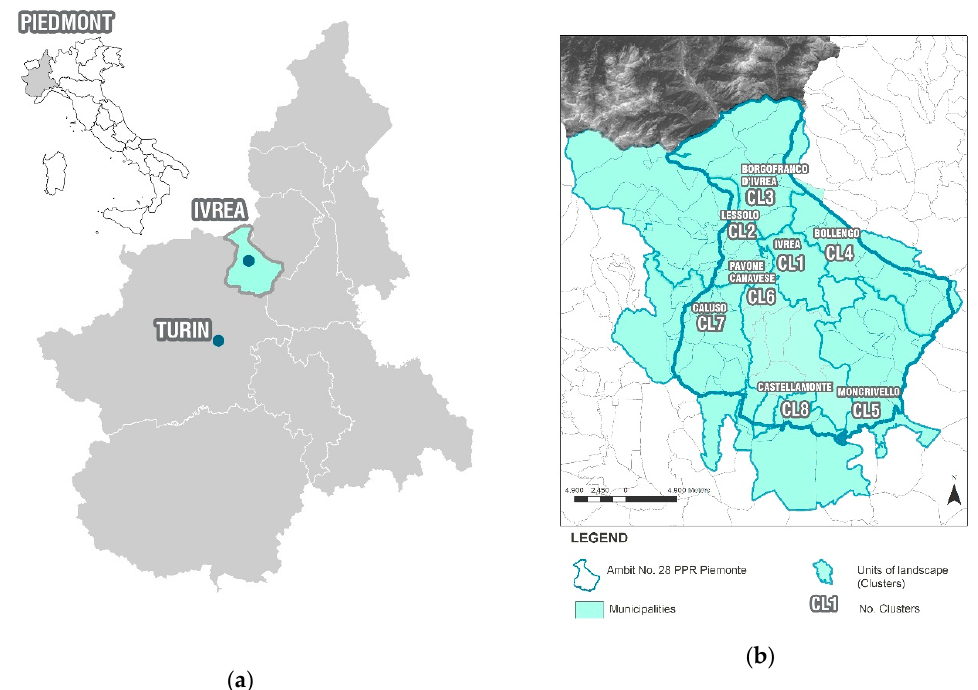
Figure 1. Territorial localisation of the MAI ( Moraine Amphitheatre of Ivrea ) landscape (a) and the system of territorial clusters of the MAI landscape (b).